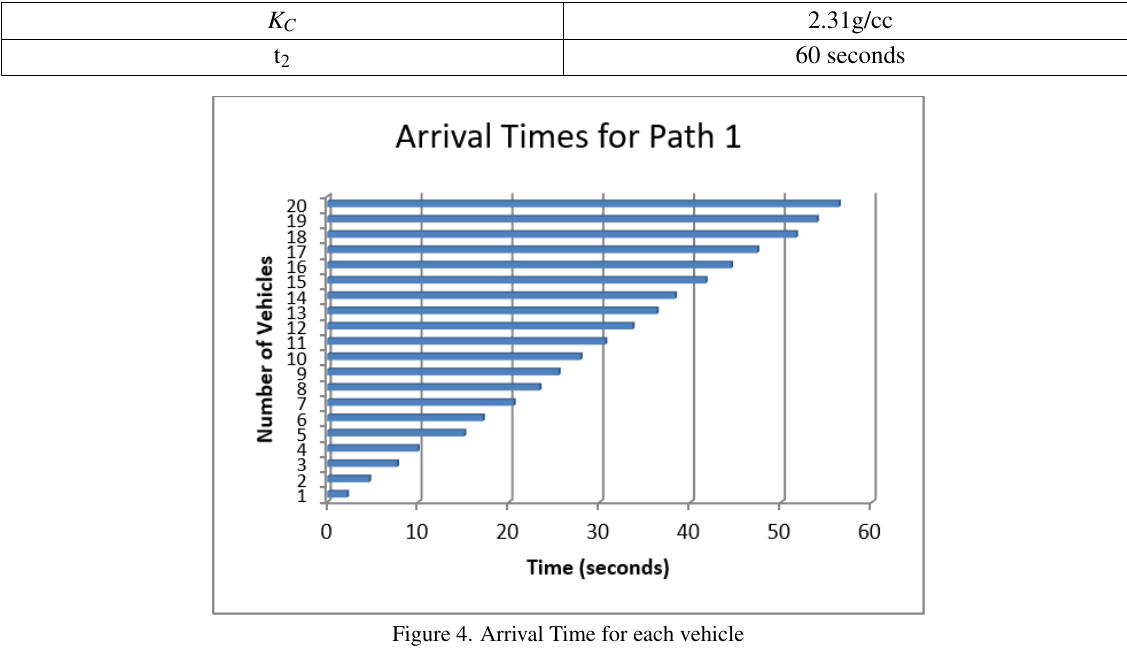
Table 2. Parameters for Evaluation